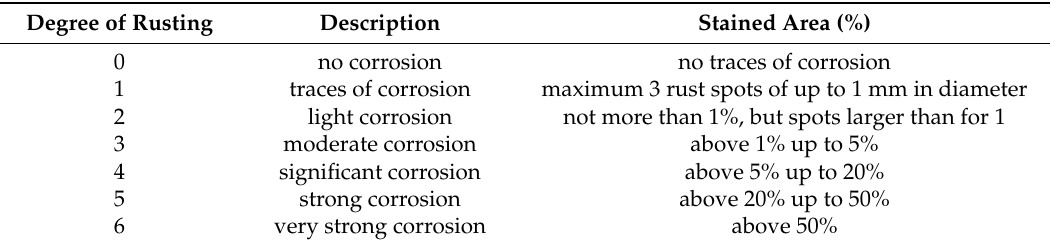
Table 1. Point evaluation of rusting degree according to PN-92/M-55789 standard.